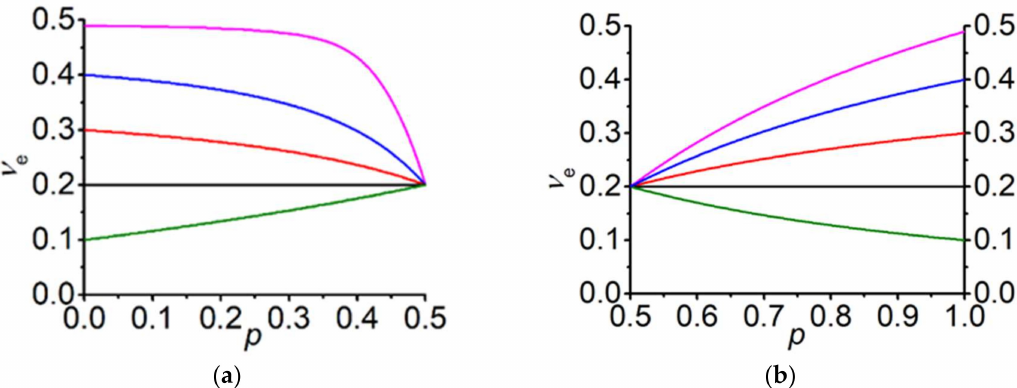
Figure 1. Concentration dependences of the e ff ective shear modulus G e at G 2 moduli of the second phase G 2 ( ν 2 = 0.49) and G 1 = ∞ . ( b ) Di ff erent shear moduli of the first phase G 1 ( ν 1 = 0.3) and G 2 = 0 Pa.